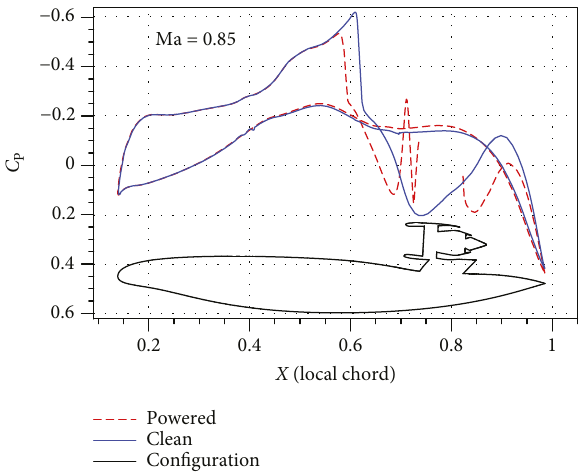
Figure 16: Surface pressure distribution of the airframe on the engine symmetry plane at the cruise